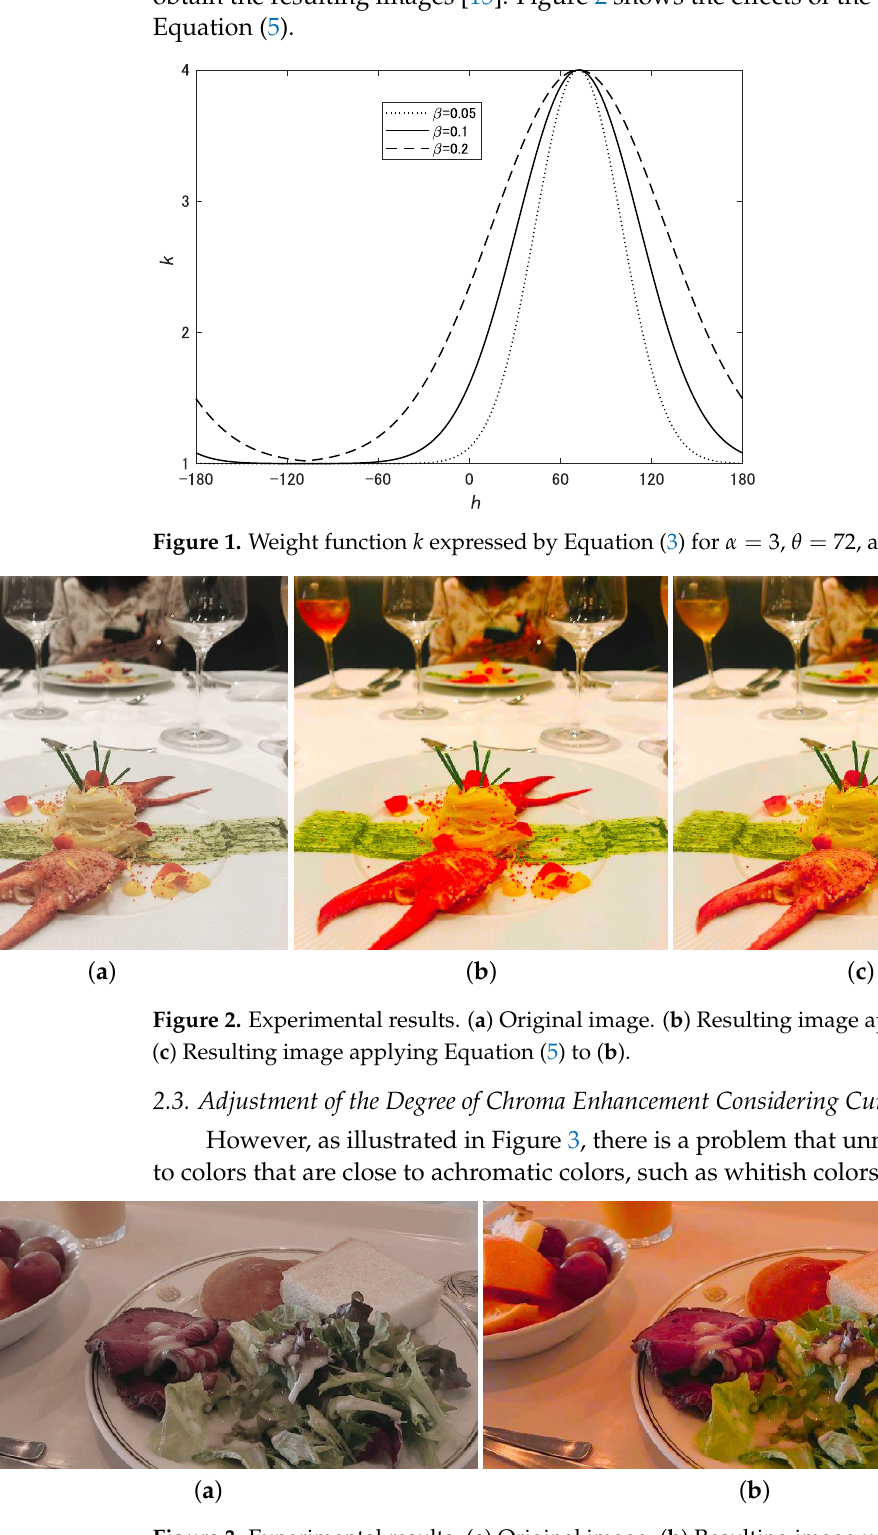
Figure 3. Experimental results. ( a ) Original image. ( b ) Resulting image using the proposed method with Equation